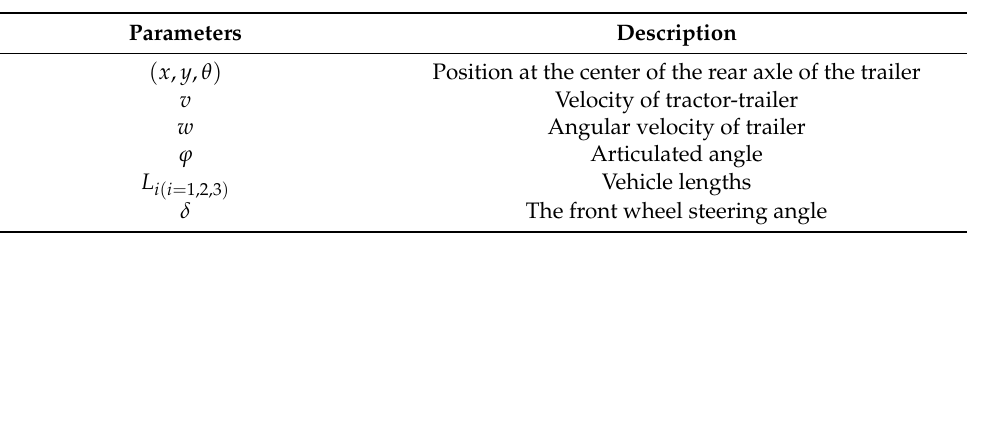
Table 1. The parameters in the tractor-trailer’s kinematic